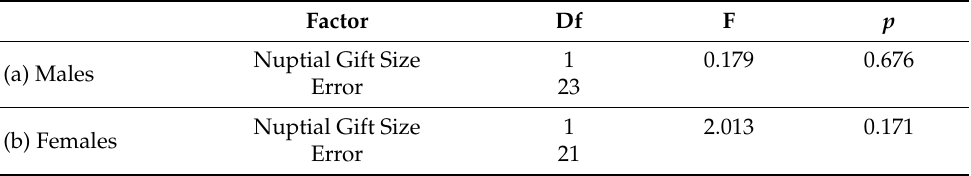
Table 2. The results of the general linear model analysis of preferred temperatures of mated Cal- losobruchus maculatus beetles (individuals allowed to mate once). Analyses for each sex were per- formed independently. Nuptial gift size was expressed in relative values as the proportion of initial body mass gained by females or lost by males following a single